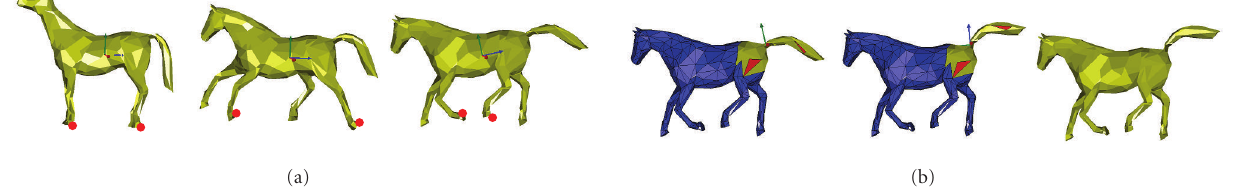
Figure 6: Editing a horse (1k triangles) with translations and rotations. By translating the handles on the feet, we can pose the horse naturally (a). Once the overall pose is determined, the user edit the pose locally with the rotational control, if required (b). The blue region is frozen so that deformations remain local.